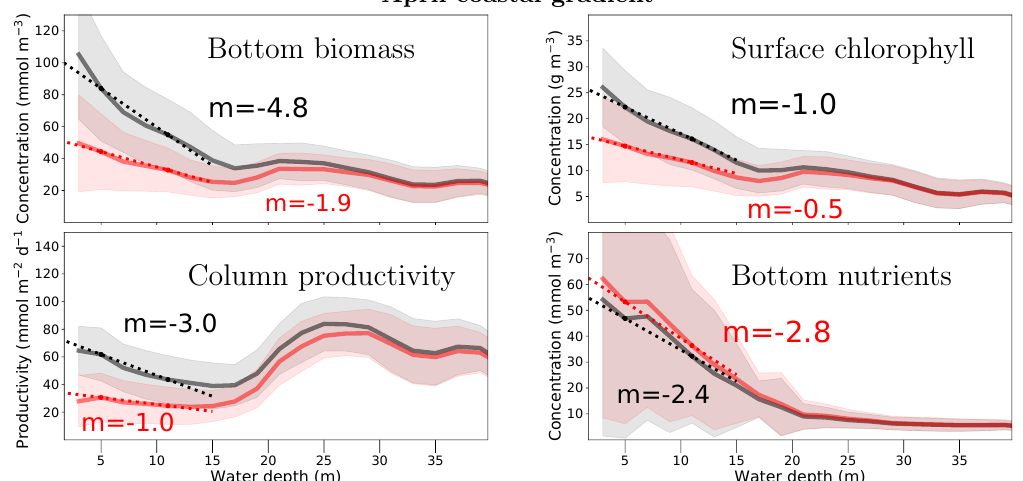
Figure 7. Climatological April coastal gradient for simulations with (red) and without (black) filtration. Coastal gradient is shown as quantity versus water depth, for bottom biomass (phytoplankton carbon), surface chlorophyll, total water column net primary productivity, and bottom dissolved organic nitrogen. Solid lines are averaged over all data within a 2-m depth interval, shading indicates the ± 1 σ deviation within each band. The dotted lines show gradient and slope (given in quantity change per m water depth) between the 11 ± 1 m and 5 ± 1 m depth